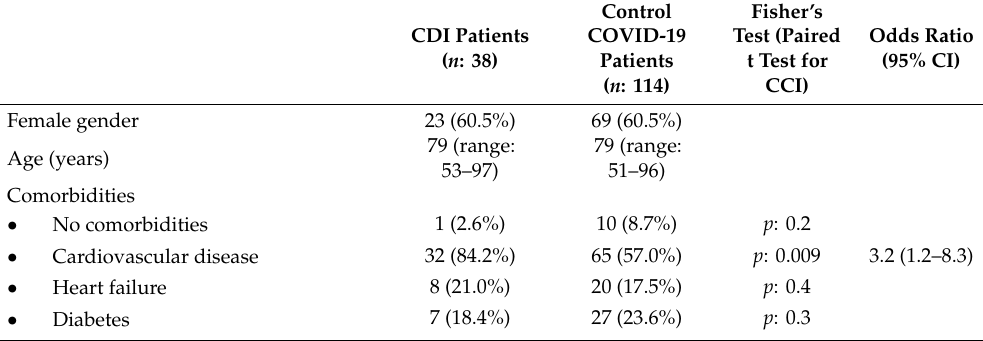
Table 1. Demographic and epidemiological data, comorbidities, clinical characteristics of the Coronavirus Disease 2019 (COVID-19) and outcome of the 38 COVID-19 patients with CDI and of the 114 COVID-19 controls included in the study. CCI: Charlson Co-morbidity Index. LTHCF: long-term health care facility. ARDS: Acute Respiratory Distress Syndrome. LMWH: Low Molecular Weight Heparin. CI: confidence